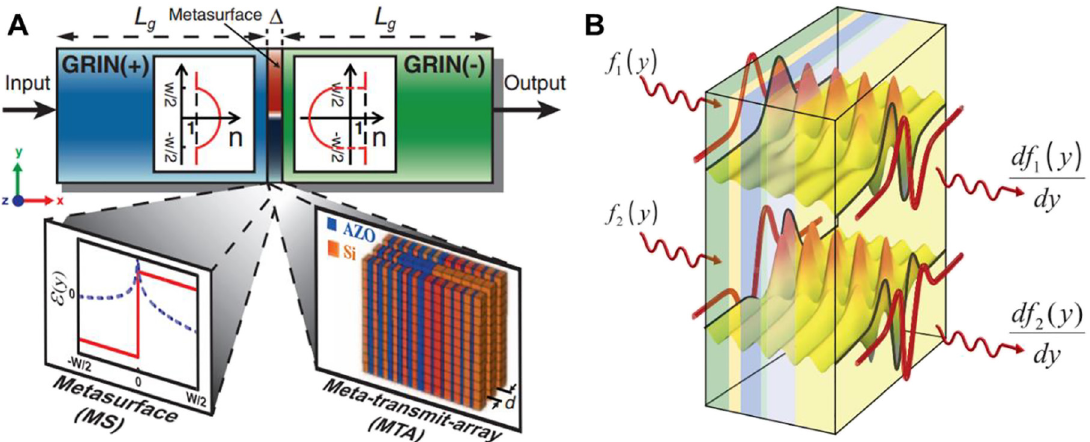
Figure 2: Wave-based computational metamaterials